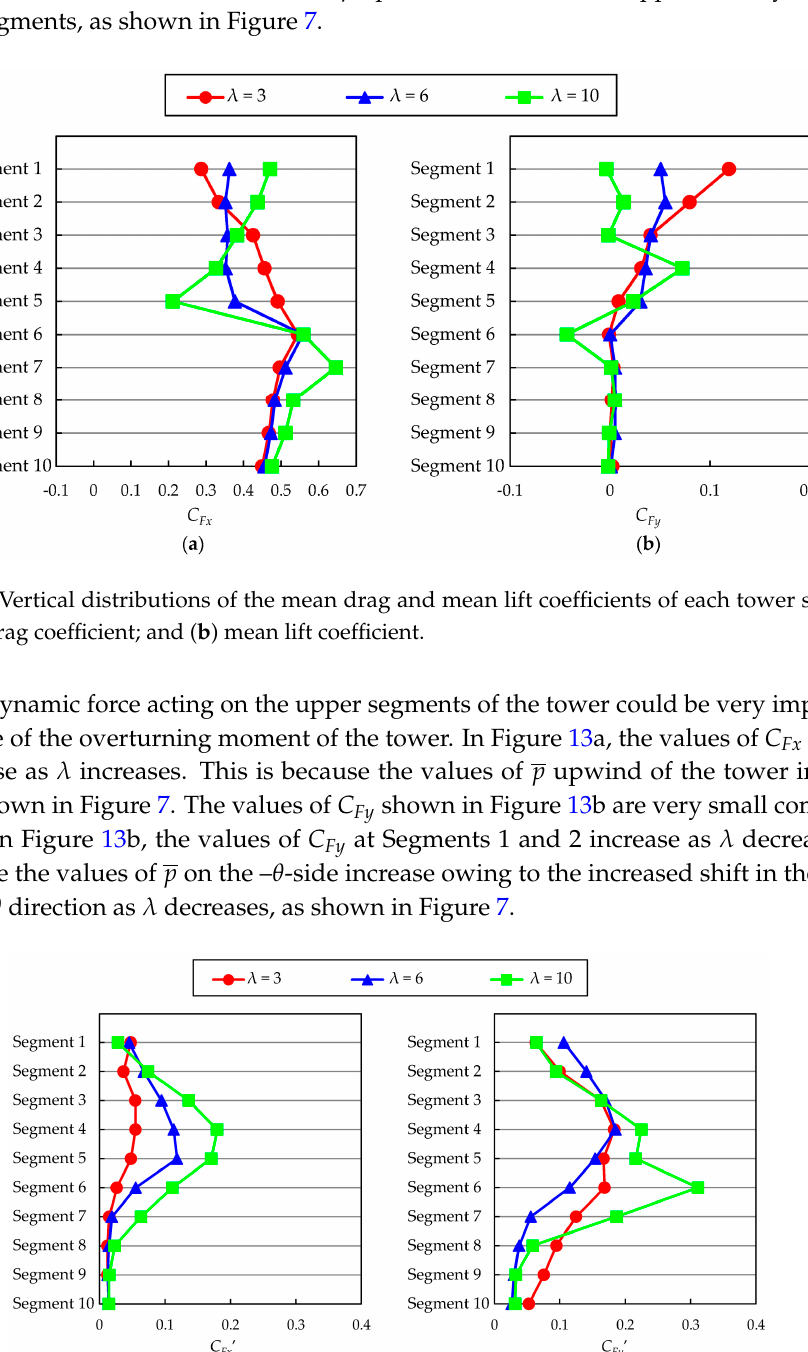
Figure 14. Vertical distributions of the fluctuating drag and fluctuating lift coefficients of each tower segment. ( a ) Fluctuating drag coefficient; and ( b ) fluctuating lift coefficient.